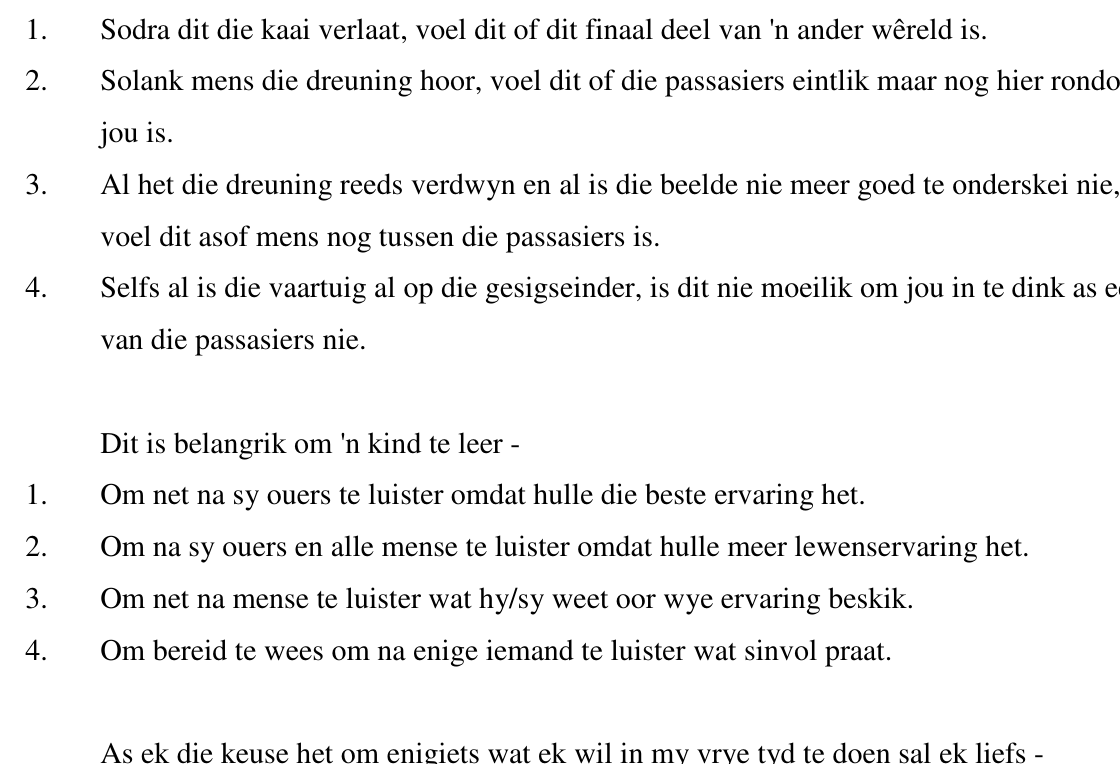
Perspektiewe in die Bedryfsielkunde 1980 7.2